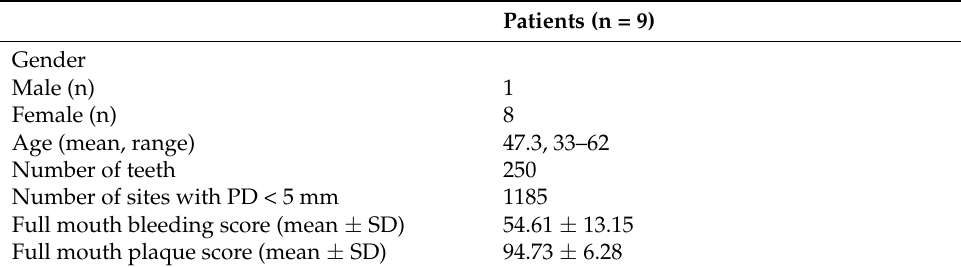
Figure 1. Flowchart. Table 1. Baseline characteristics.